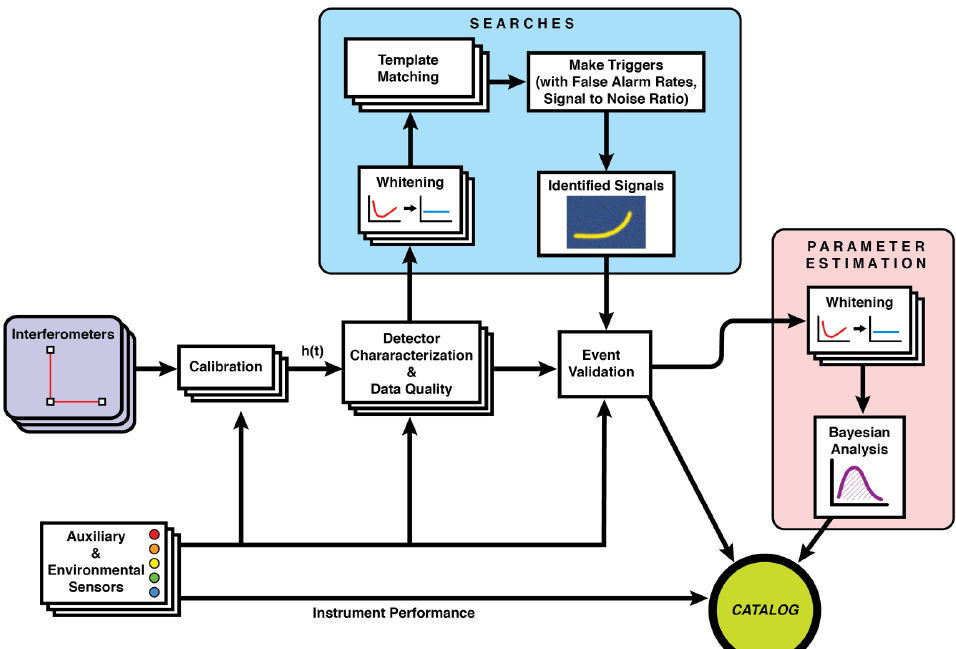
Figure 1. A visualization of the connections between different components of gravitational-wave data analysis. Detector characterization is in the middle, indicating its critical role in gravitational-wave astronomy, as it contributes to many different steps of the process, from improving the detectors to checking candidate gravitational-wave signals for any possible pollution by nose artifacts. Figure reproduced from [24]. © IOP Publishing. Reproduced with permission. All rights